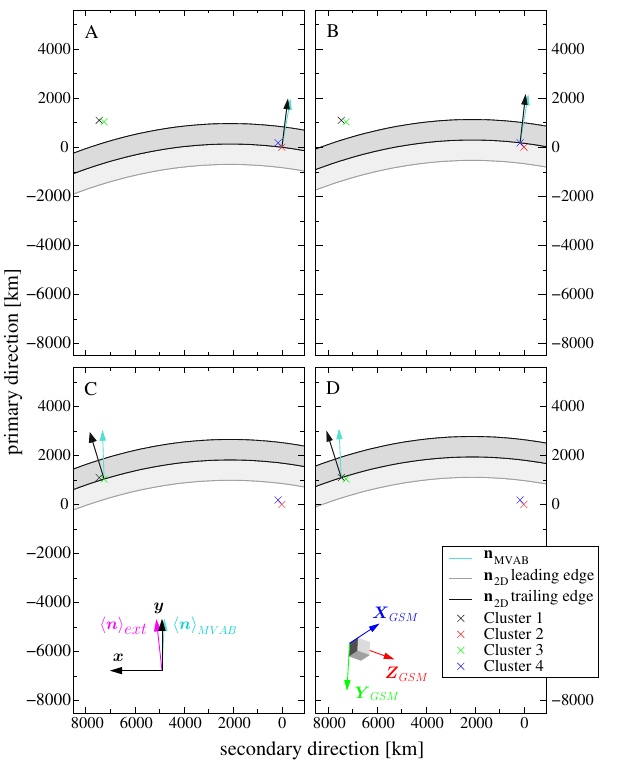
Fig. 8. The 2-D, non-planar MP motion in the plane perpendicular to the invariant direction, according to the P1 OpTA solution. For a description of this picture see the text.